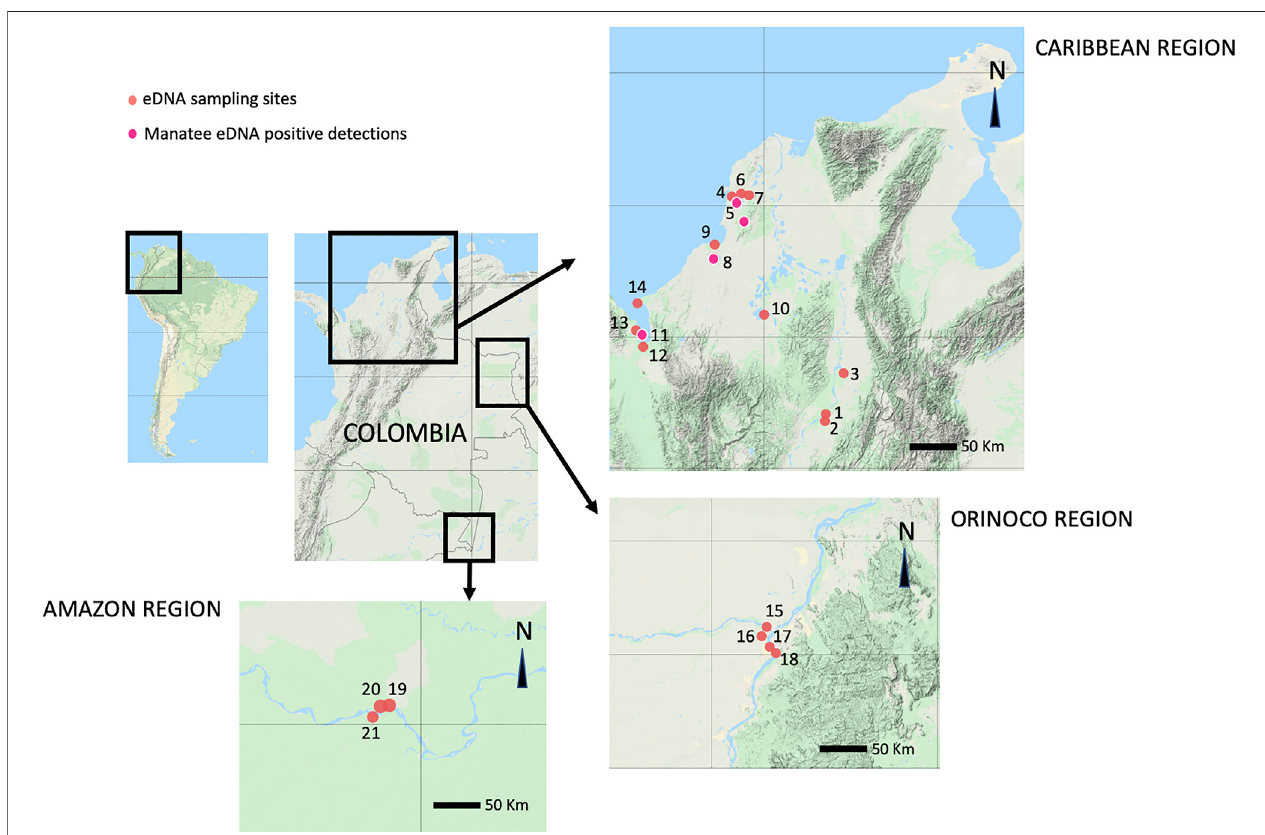
FIGURE 2 | Environmental DNA sampling sites: 1. Chucuri Marsh, 2. San Juan River, 3. Paredes Marsh, 4. De las Flores Marsh, 5. Canal del Dique, 6. EL Floral Marsh, 7. Batallion Lake, 8. Lorica Marsh, 9. Cispata Bay, 10. Ayapel Marsh, 11. Atrato River mouth, 12. Suriqui River mouth, 13. Marriaga Marsh, 14. Rio Negro Cove, 15. Meta River, 16. Vita River, 17. Orinoco River, 18. Bojonawi Reserve, 19. Puerto Nariño, 20. Tarapoto Lake, 21. Caballo Cocha Lake. In bright pink, manatee eDNA positive detection sites: 5. Canal del Dique, 7. Batallion Lake, 8. Lorica Marsh, 11. Atrato River